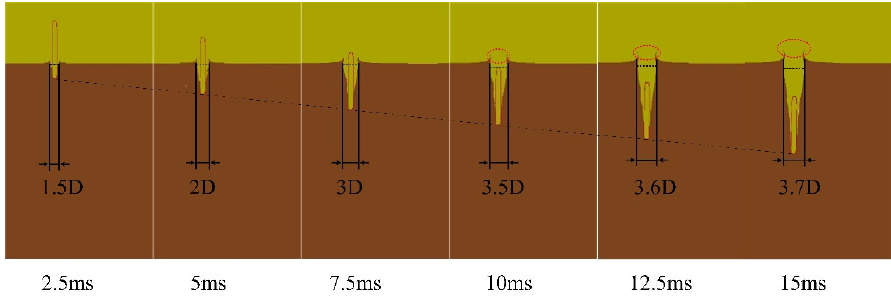
Figure 7. Cavitation of vehicle entering water at speed of 175 m/s and angle of 90 °.